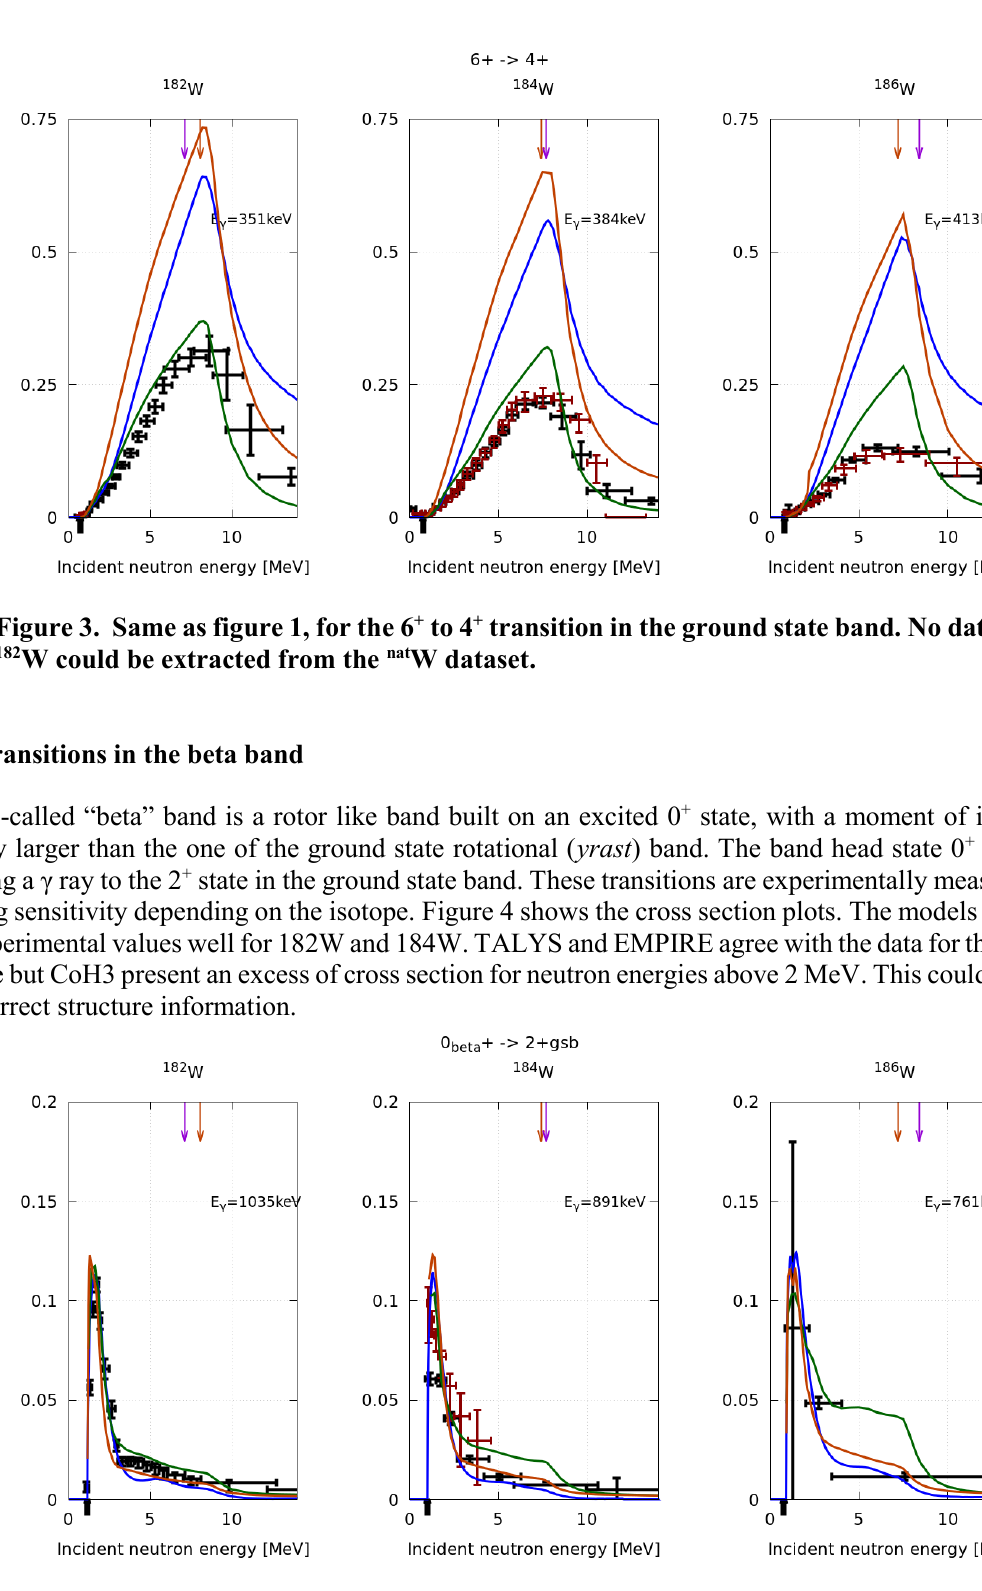
to 2 + transition. Data could be extracted from beta gsb